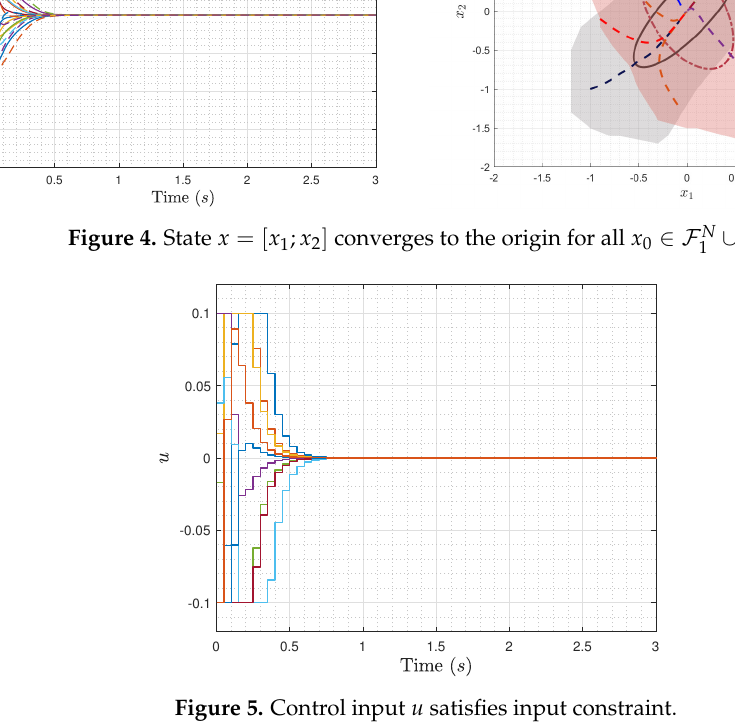
Figure 5. Control input u satisfies input